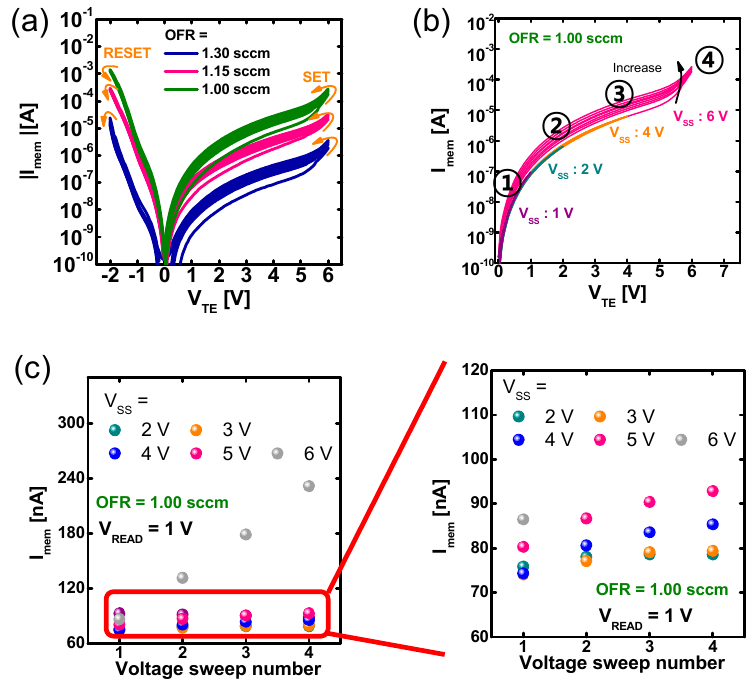
Figure 2. ( a ) The (oxygen flow rate) OFR-dependent I − V characteristics repeated four times. ( b ) The I − V characteristics with OFR = 1 sccm repeated four consecutive times with changes made to the (stop voltage of the V TE sweep) V SS . ( c ) The V SS -dependent readout current I mem at V TE = 1 V.